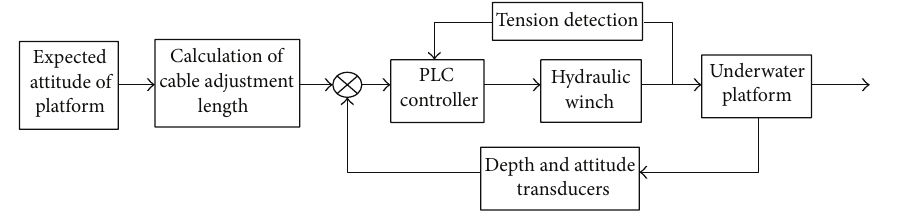
Figure 6: Control principle